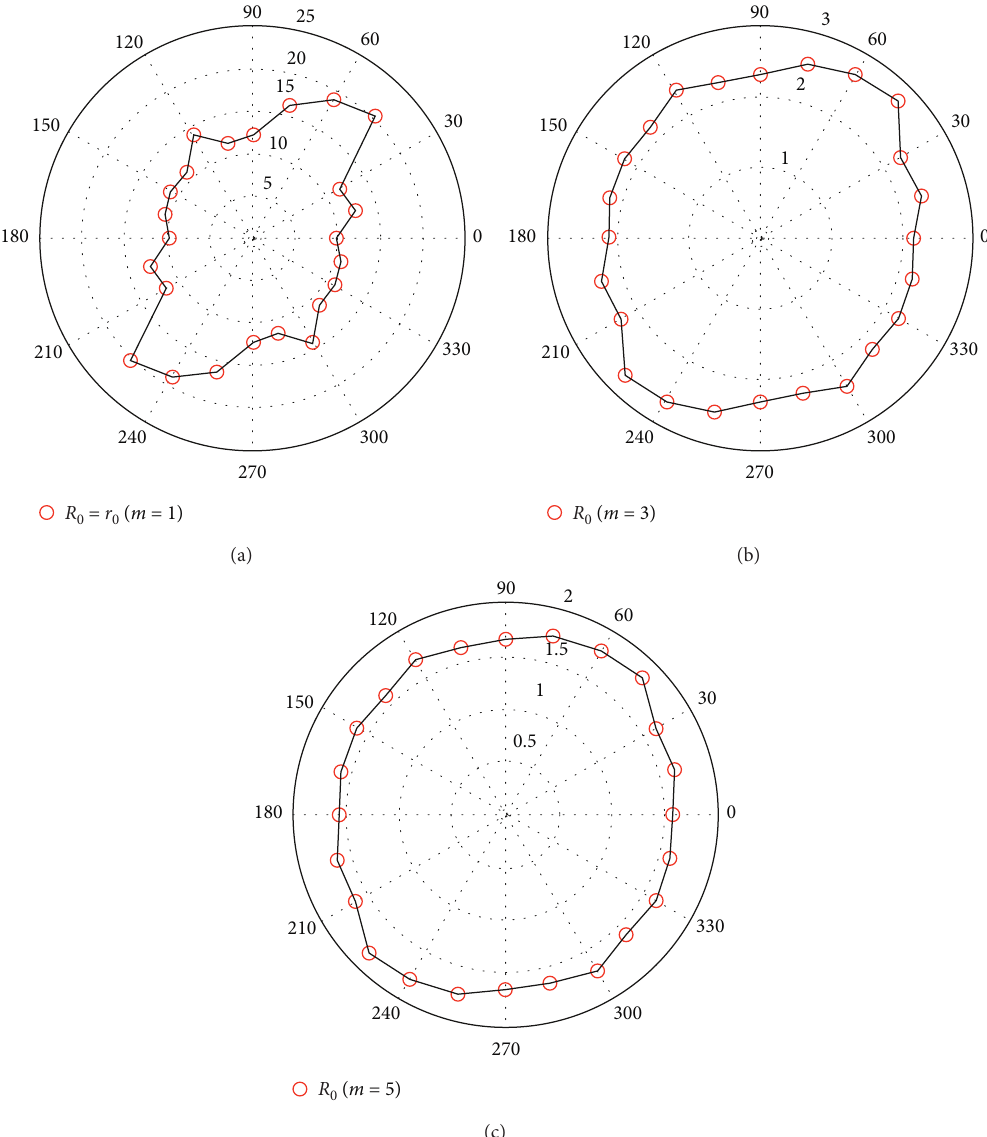
Figure 1: Polar plots of the processed JRC values. (a) m � 1; (b) m � 3; (c) m �